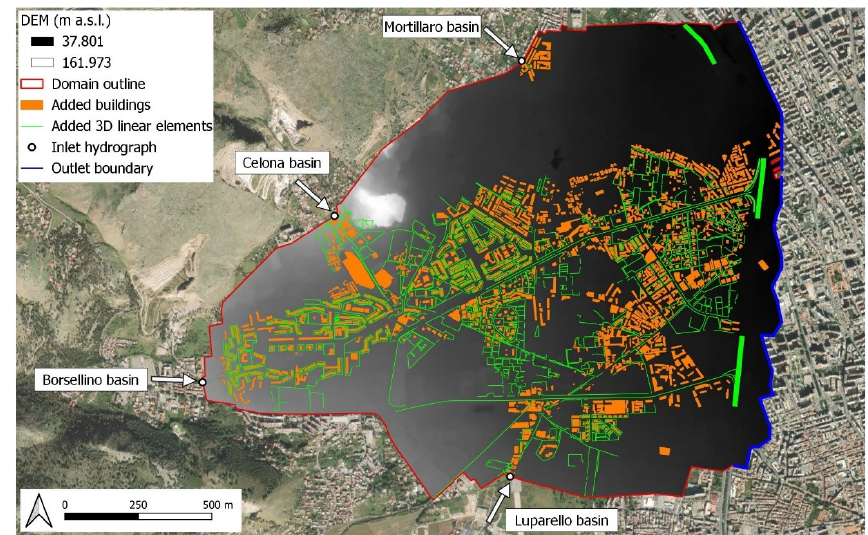
Figure 10. Domain reconstruction for the 2D hydraulic simulation in WEC-FLOOD. Source: © Google Maps Satellite basemap available within the QuickMapServices plugin of Quantum GIS.